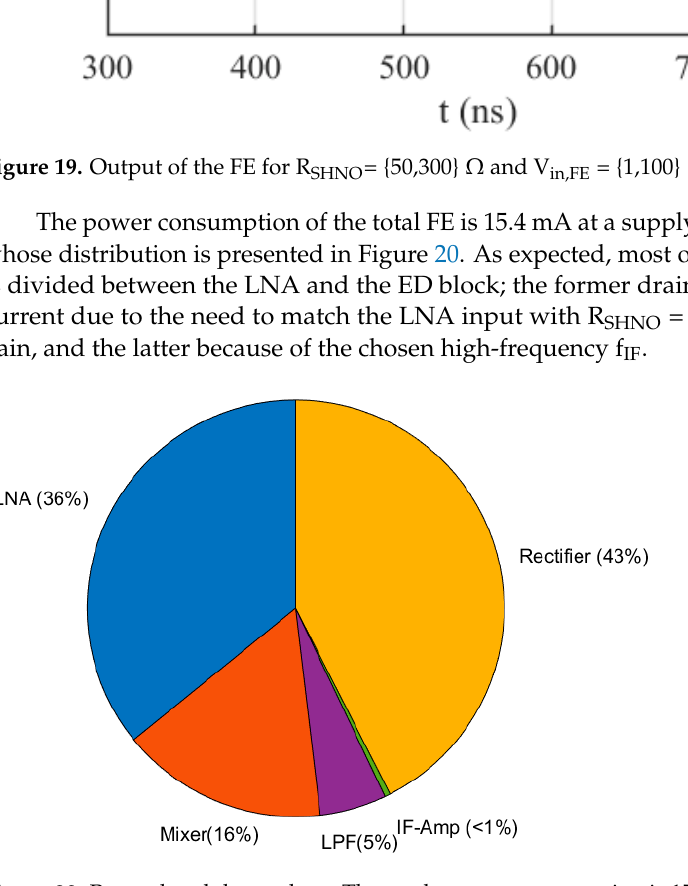
Figure 20. Power-breakdown chart. The total current consumption is 15.4 mA at V DD = 1.8 V.